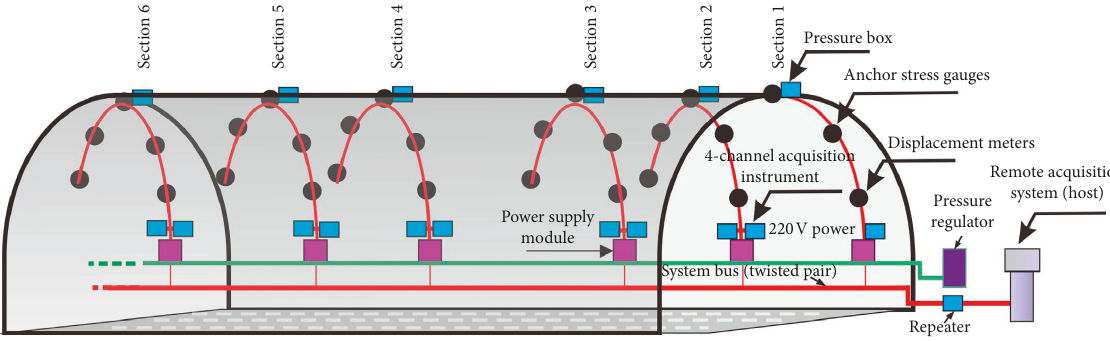
Figure 8: Network transmission route inside the